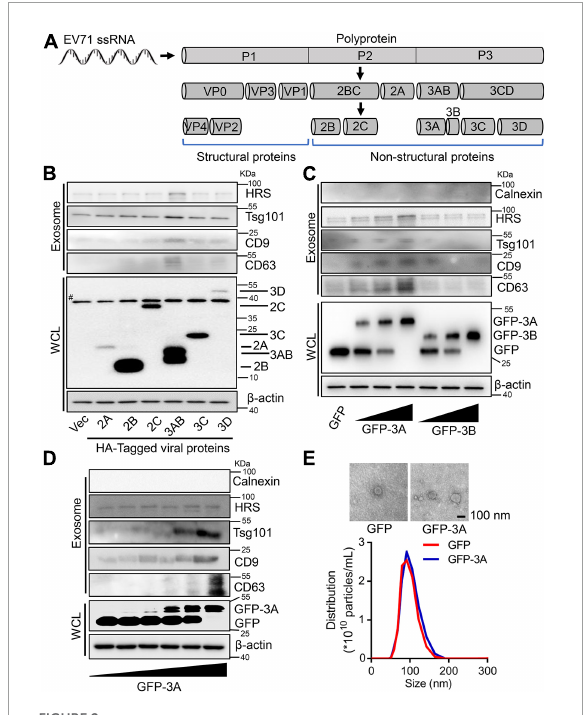
FIGURE2 Enterovirus 71 (EV71) 3A protein increases exosome biogenesis. (A) Schematic diagram of EV71 structure and non-structural proteins. (B–D) RD cells were transfected with 2 µ g plasmids expressing HA-tagged EV71 non-structural proteins (B) , or different doses (0, 0.5, 1, and 2 µ g) of plasmids expressing GFP-tagged 3A or 3B protein (C) , or different doses (0, 0.2, 0.5, 1, 1.5, and 2 µ g) of plasmids expressing GFP-tagged 3A protein (D) . At 24 h post-transfection, the extracted exosomes from cell